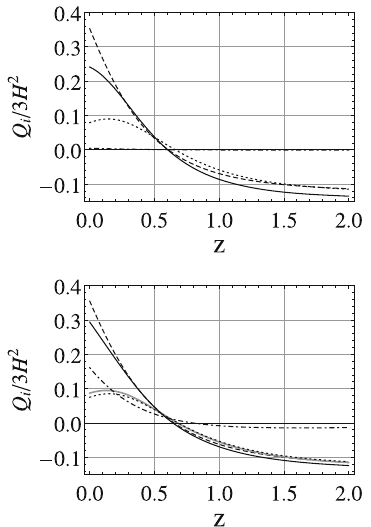
Fig. 1 Evolution of a dimensionless interaction term. The top panel corresponds to γ x = 0 and the bottom panel to a fitted γ x , both fig- ures consider the analysis JLA + H 0 + H(z). The black lines are for interacting models, dashed, dotted, dot-dashed and solid lines represent interactions Q 1 , Q 3 , Q 4 and Q , respectively. On the top panel Q 2 is indistinguishable from Q 3 , on the other panel Q 2 corresponds to the gray